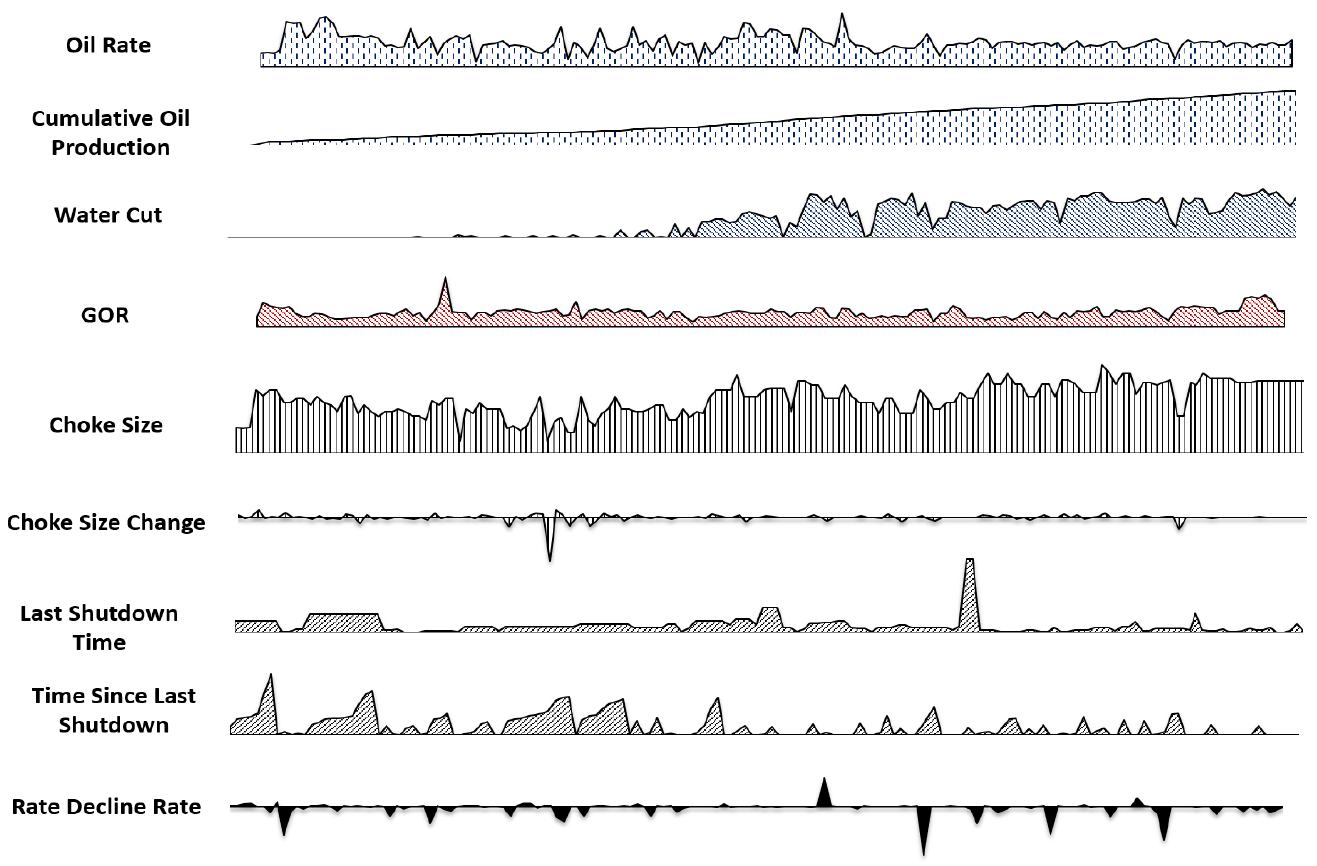
Figure 5. Extracted long-term (cumulative oil production, water cut, gas oil ratio (GOR)) and short-term time-series features (oil rate, choke size, choke size change, last shutdown time, and time since the last shutdown).